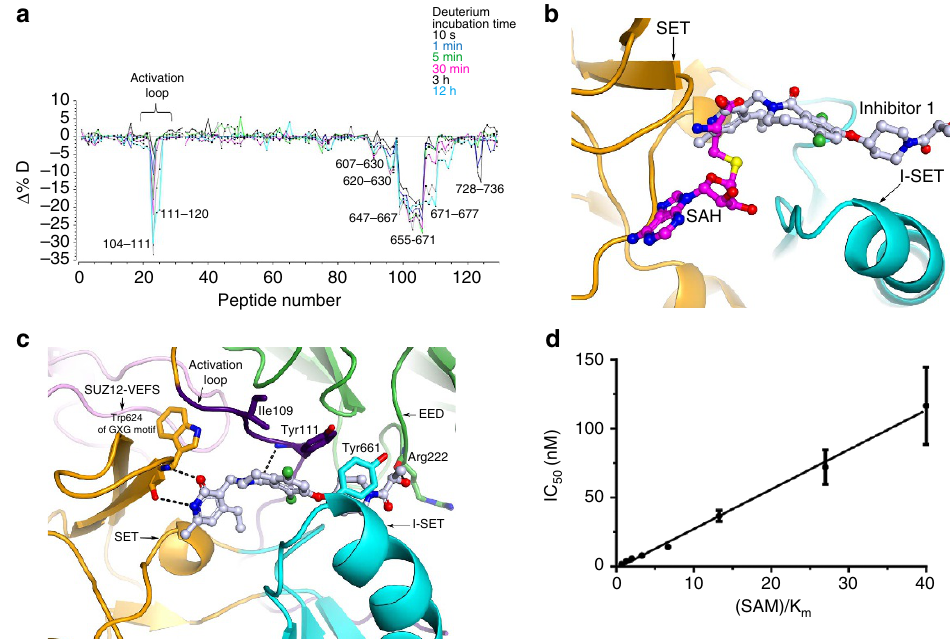
Figure 7 | PRC2 recognition of inhibitor 1 is orthogonal to the SAM-binding mode and involves the activation loop. ( a ) Differential deuterium uptake plots of EZH2 subunit of PRC2 with and without the inhibitor highlights dynamic changes in the activation loop, which is also the site of certain resistance-conferring mutations generated in vitro to first-generation PRC2 inhibitors. Deuterium incubation times: 10s,1min, 5min, 30min, 3h and 12h. ( b ) Ligand binding relative to SAM recognition. SAM is modelled in purple based on the Ct PRC2 structure 5 . The SETdomain is shown in orange with I-SET highlighted in cyan. ( c ) Some of the details of the inhibitor recognition are illustrated. Activation loop is shown in indigo and EED is shown in green. ( d ) Plot of IC 50 values of compound 1 as a function of SAM concentration relative to the K m of SAM ((SAM)/ K m ) measured using histone methyltransferase activity assay with Hs PRC2_4 as described in the Methods section (plotted as mean ± s.d. of two independent experiments). These values show a linear relationship, as expected for a SAM-competitive